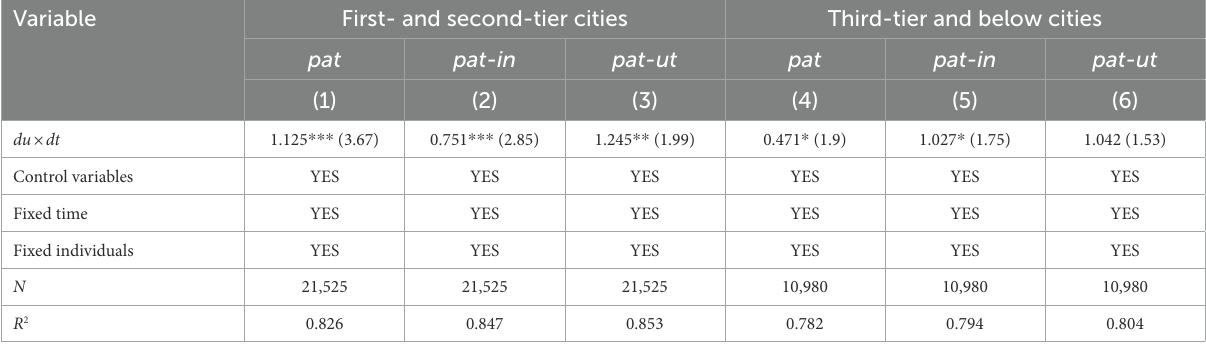
TABLE 4 Test results of heterogeneity of economic development strength. Variable First- and second-tier cities Third-tier and below